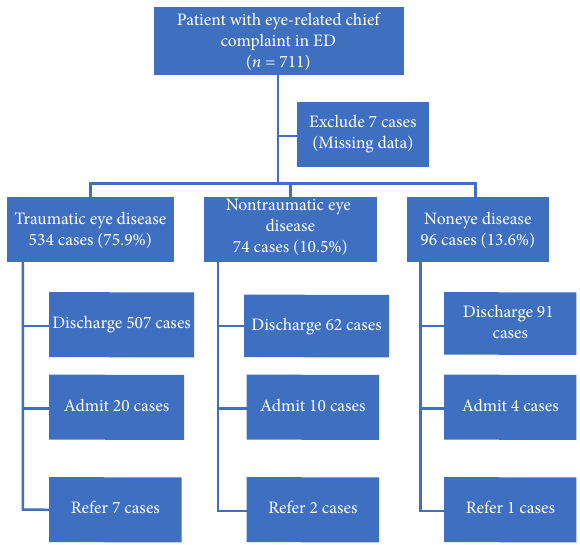
Figure 1: Flowchart of the study. Table 1: Characteristics of 704 patients with eye-related chief